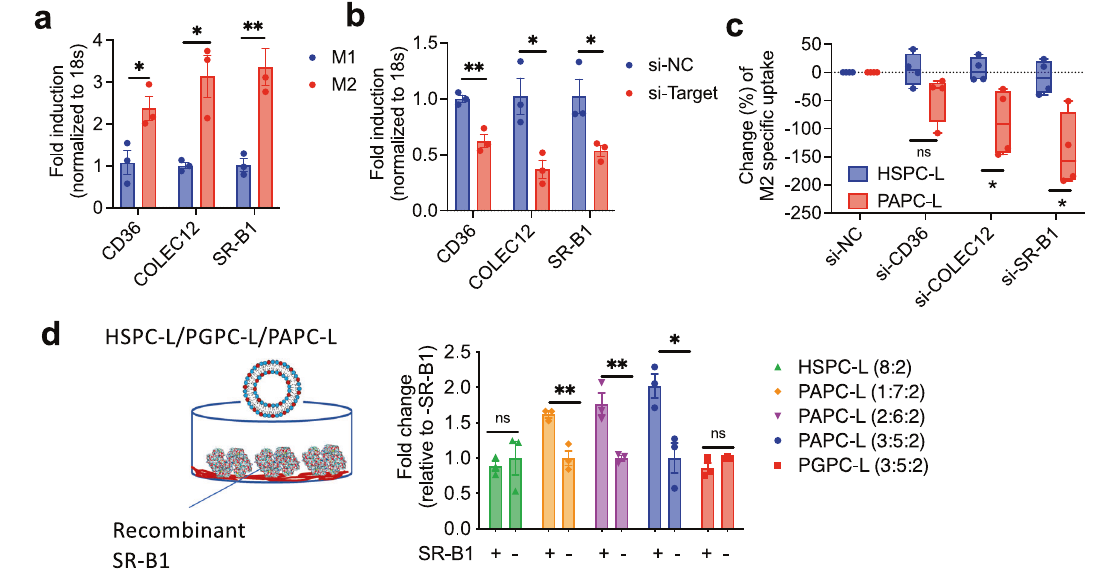
Fig. 2 | Role of scavenger receptors in uptake of M2-targeted nanoliposomes. a mRNAexpressiondatashowingtheupregulationofM2speci fi csurfacereceptors CD36, COLEC12 and SR-B1 compared to M1 (left to right: * p =0.032, * p =0.013, ** p =0.0068). Data represents mean ± standard error of the mean (SEM) for three independent experiments. Statistical analysis was performed with multiple unpaired t-tests with correction for multiple comparisons using the Holm-Sidak ’ s method. b Knockdown of CD36, COLEC12 and SR-B1 using siRNA technique shows reduced gene expression levels of CD36, COLEC12 and SR-B1 in M2 macrophages (left to right: ** p =0.0049, * p =0.022, * p =0.040). Data represent mean±SEM for three independent experiments. Statistical analysis was performed with Multiple unpaired t-tests with correction for multiple comparisons using the Holm-Sidak ’ s method. c Quantitation of fl ow cytometry analysis showing percentage change in